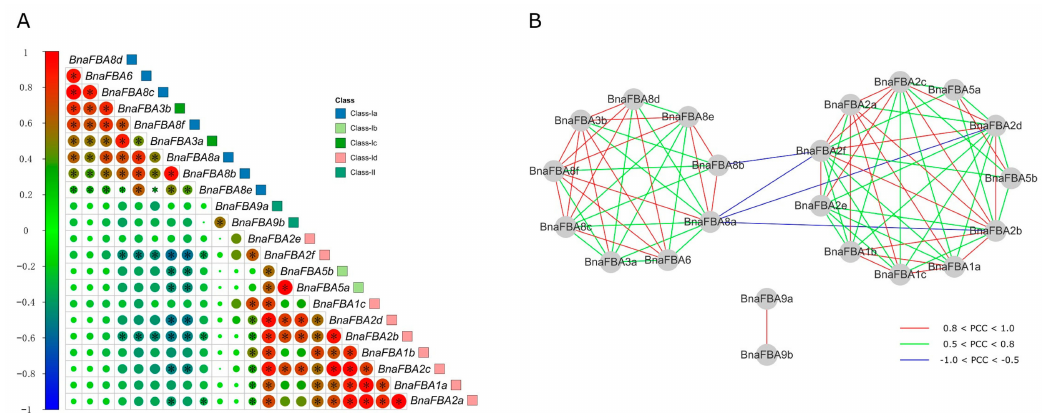
Figure 8. Correlations and co-regulatory networks of BnaFBA genes. ( A ) Correlation analysis of BnaFBA genes was performed based on the Pearson correlation coe ffi cients (PCCs) of BnaFBA gene pairs. Correlations are indicated by the size and color of circles. The left bar represents the correlation values of PCCs. The class information for BnaFBAs is indicated by the squares with di ff erent colors at the right. Black star signifies the correlation with p -value ≤ 0.05. ( B ) The co-regulatory network of BnaFBA genes was generated on the basis of the significant PCCs of gene pairs ( p -value ≤ 0.05). The distinct correlation levels of gene pairs are marked by edge lines with di ff erent colors shown at the bottom. The co-regulatory network was illustrated by Cytoscape (version 3.1, Seattle, WA,